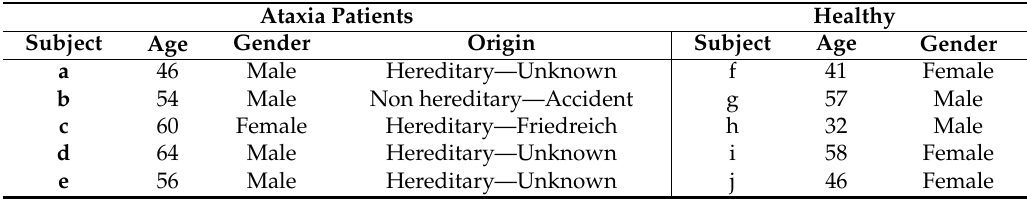
Table 1. Characteristics of the Subjects Involved in the Tests.